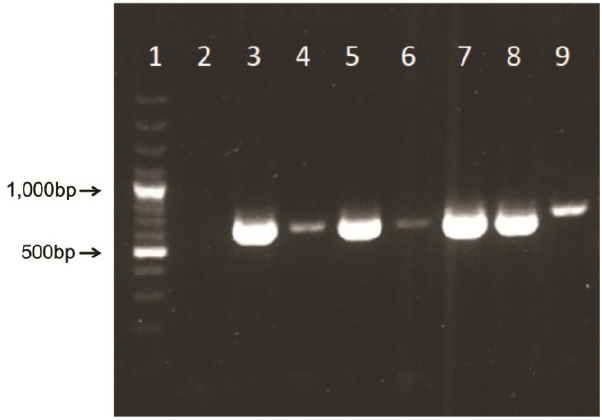
Figure 3. Gel electrophoresis showing 632 bp polymerase chain reaction (PCR) products of the amplified hexon gene fragment. Lane 1 : molecular mass marker (DNA ladder 100 bp plus); lane 2 : negative control; lane 3 : passage XI of NPU cell culture; lane 4 : passage XI of NPU cell culture, 10-fold dilution; lane 5 : passage XIII of NPU cell culture; lane 6 : passage XIII of NPU cell culture, 10-fold dilution; lane 7 : passage X of NPU cell culture;